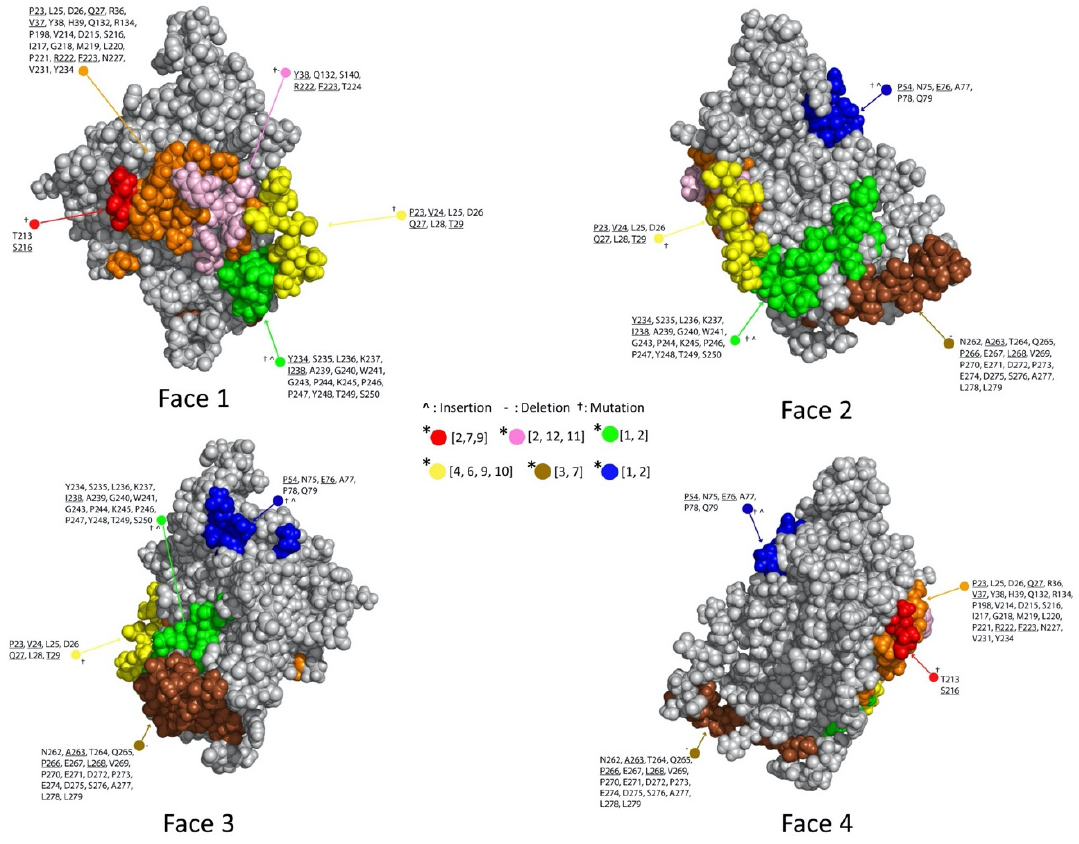
Figure 7. Experimentally probed residues. Residues with associated experimental binding data are labeled; bracketed numbers in the legend indicate primary references in the bibliography. The surface is colored by associated Abs (Supplementary Figure S1), rather than dock binning community. The residues that were also highlighted by dock binning are underlined; this data serves as probes of those particular predicted antigenic hotspots.